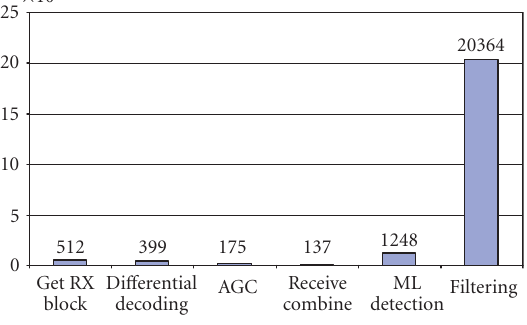
Figure 7: VT-STAR receiver DSP profiling